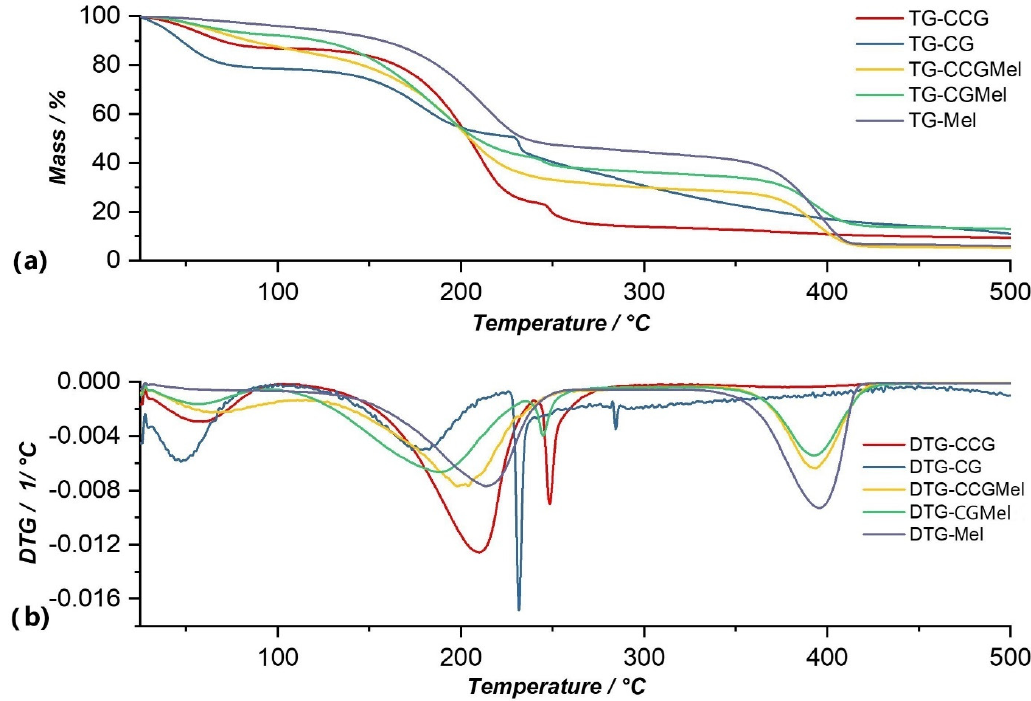
Figure 6. Comparison of TG ( a ) and DTG ( b ) curves of Mel with membranes in which this substance was incorporated (CCGMel, CGMel), as well as with control membranes (CCG and CG).